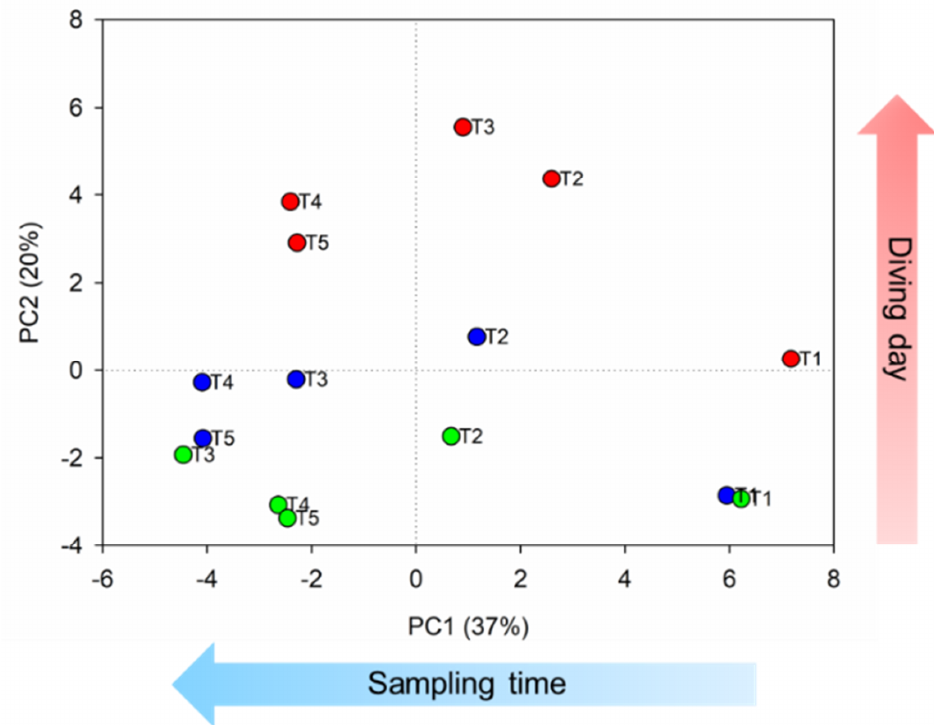
Figure 2. The PCA score plot for PC1 and PC2 of diver 1. Day 1: green; day 2: blue; day 3: red. The light blue arrow indicates the separation along PC1, while the red arrow indicates the separation along PC2. along PC2.